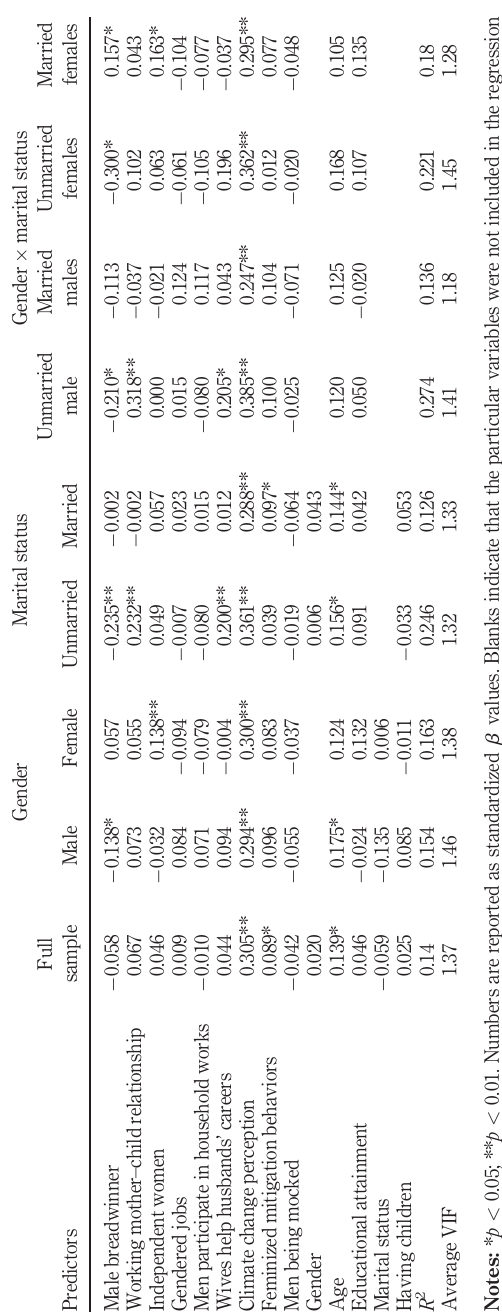
Table 4. Multiple regression analysis results (dependent